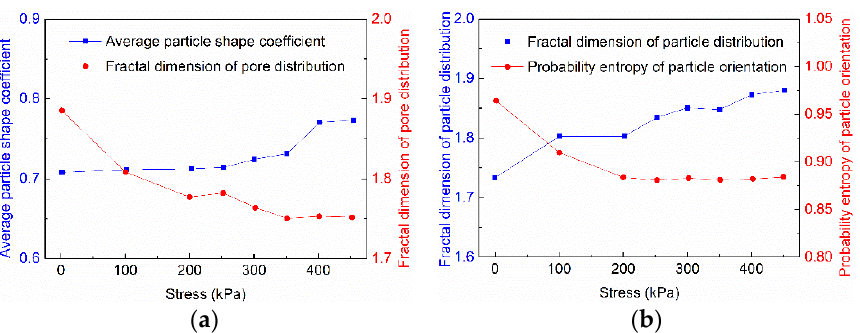
Figure 6. Relation between morphological characteristics and stress: ( a ) average particle shape coefficient and fractal dimension of pore distribution; ( b ) fractal dimension of particle distribution and probability entropy of particle orientation.